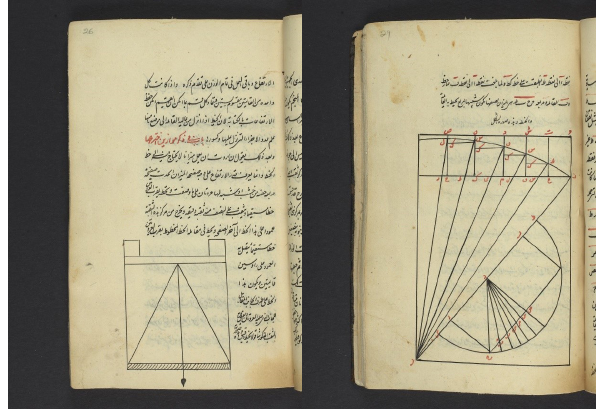
Figure 6. Illustration for the proof on how to vertically describe how to measure and determine the height of a mountain. Dia- grams f35r and f36v from Karaji (1675). Permanent link: http://hdl. library.upenn.edu/1017/d/medren/9948256513503681 (last access: 29 July